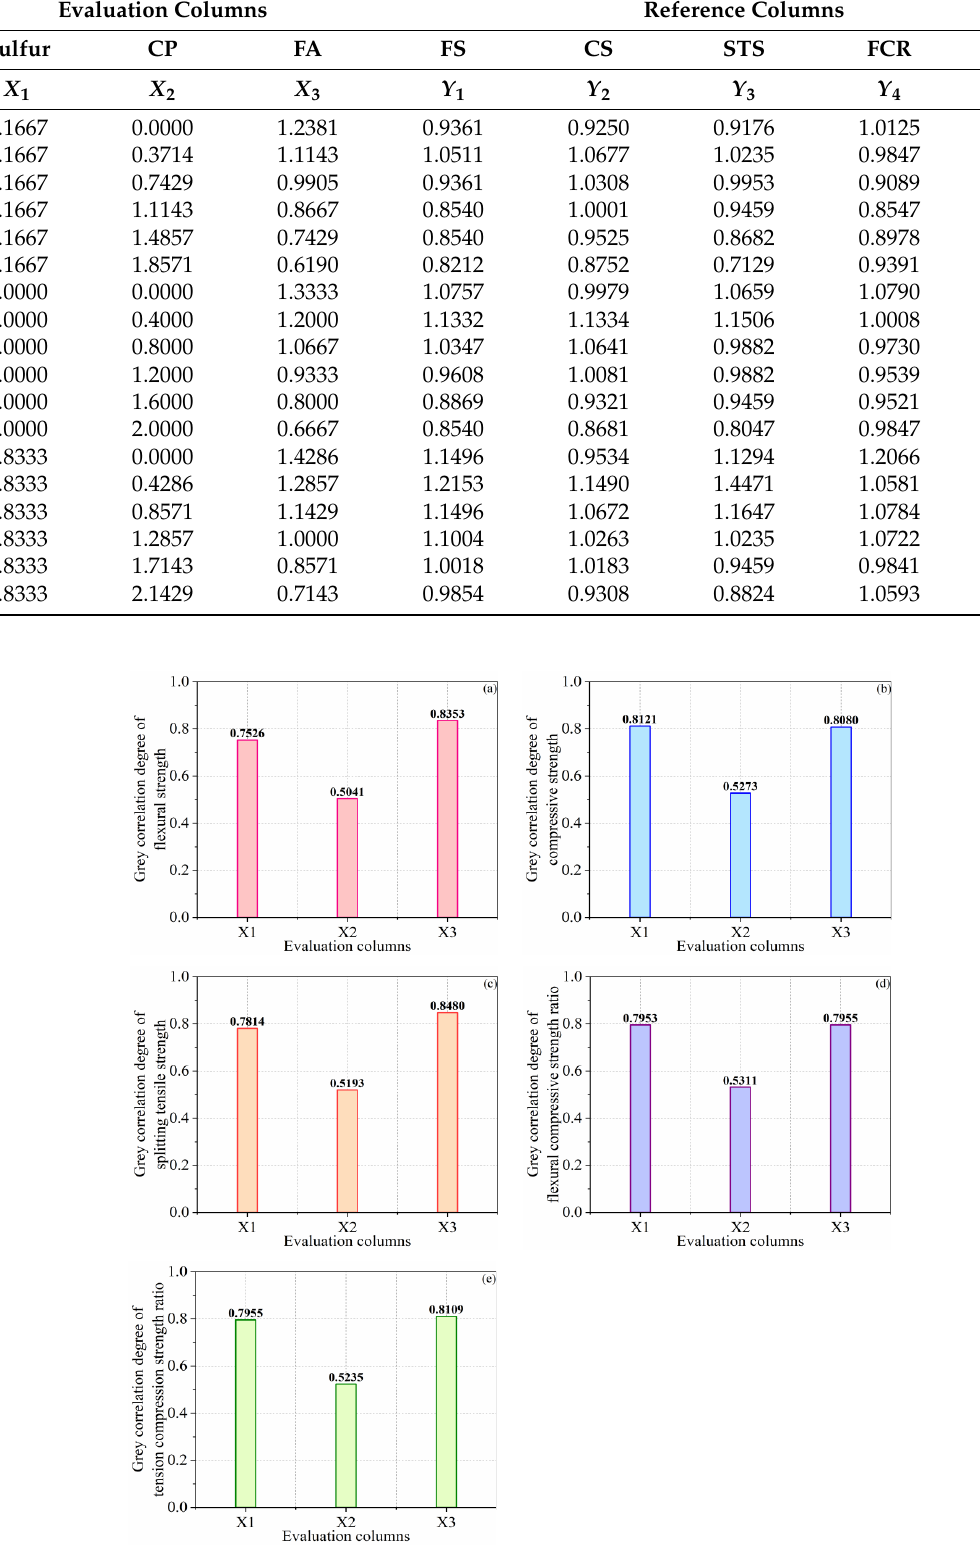
Table 6. Results of mean processing.